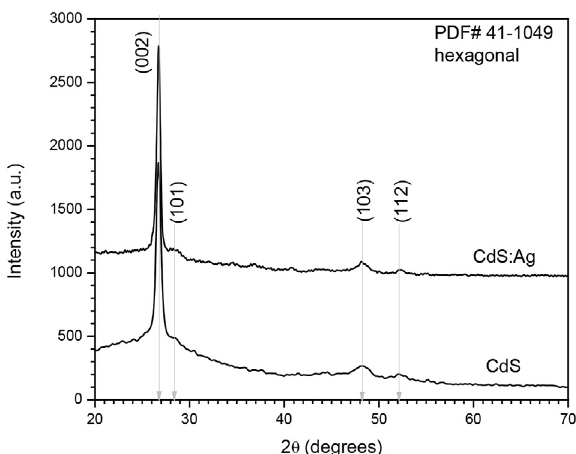
Figure 7. XRD patterns for CdS (lower) and silver coated CdS (up- per) thin films.